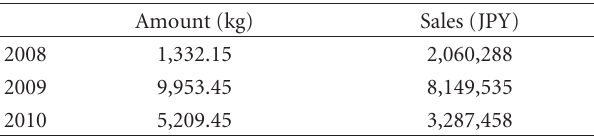
Table 10: The total amount and sales of edible wild plants sold by JA to the central market, Kanazawa, of Ishikawa